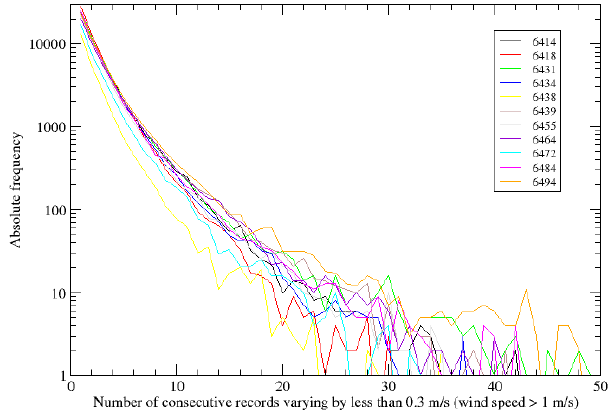
Figure 3. Frequency of occurrence of different consecutive 10m wind speed repetitions at given AWS (non-calm wind speed) gath- ered over five years (i.e., 2010–2014) of 10min wind speed records (see Table 1 for the AWS